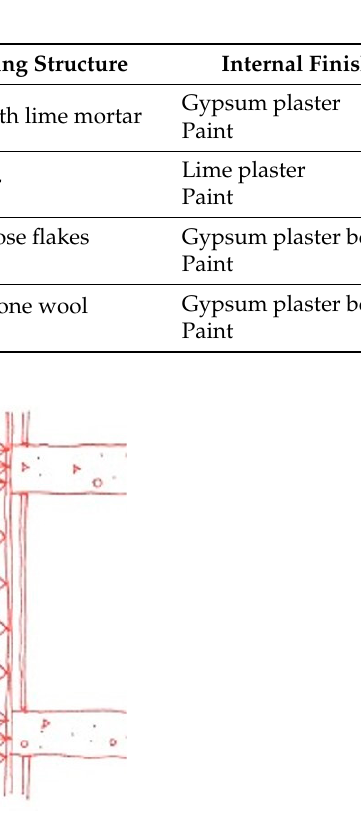
Table 3. The main components of the four external wall variants included in case study 1 are newly built primary schools.